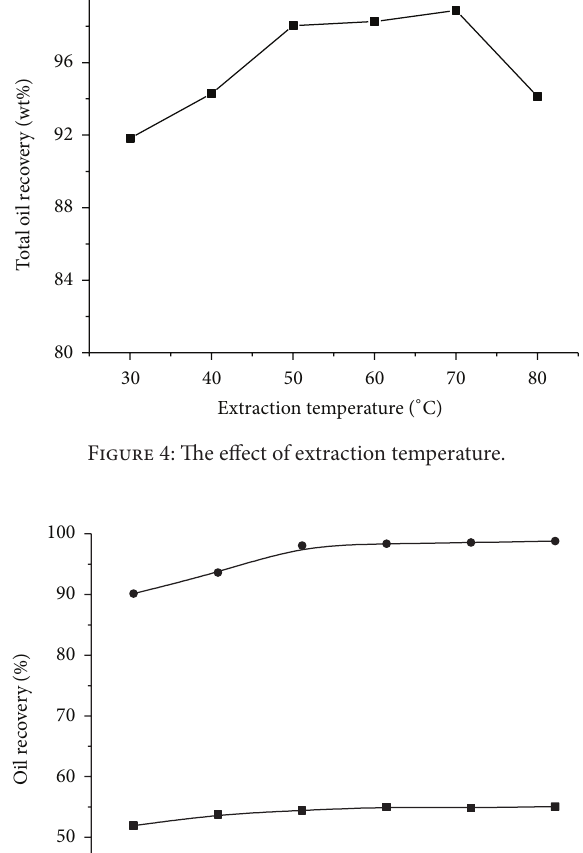
Table 4: Extraction procedure of different times.